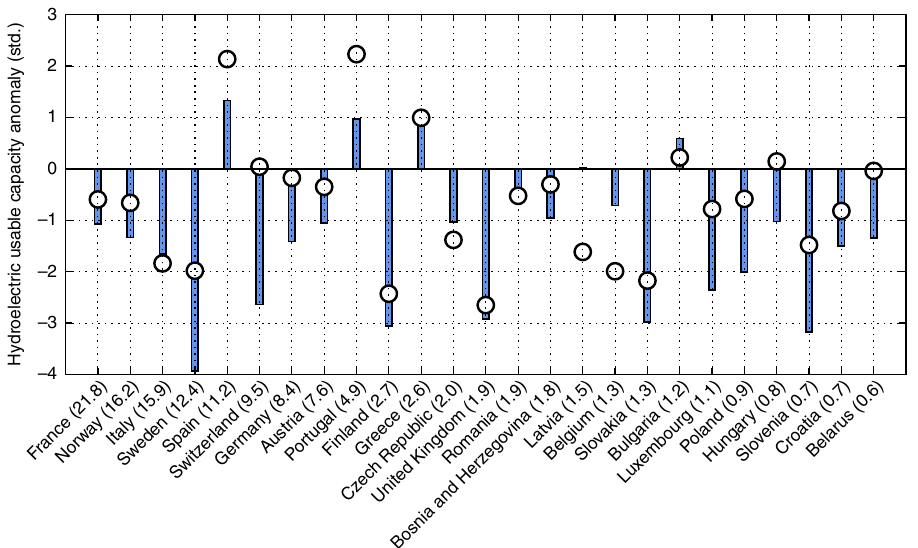
Fig. 5 Hydropower anomalies in 2003. Black circles show anomalies in annual hydropower generation reported by EIA (Methods). Blue bars show anomalies in simulated annual hydroelectric usable capacity. Countries are ordered by installed capacity (in GW) as included in the model, indicated